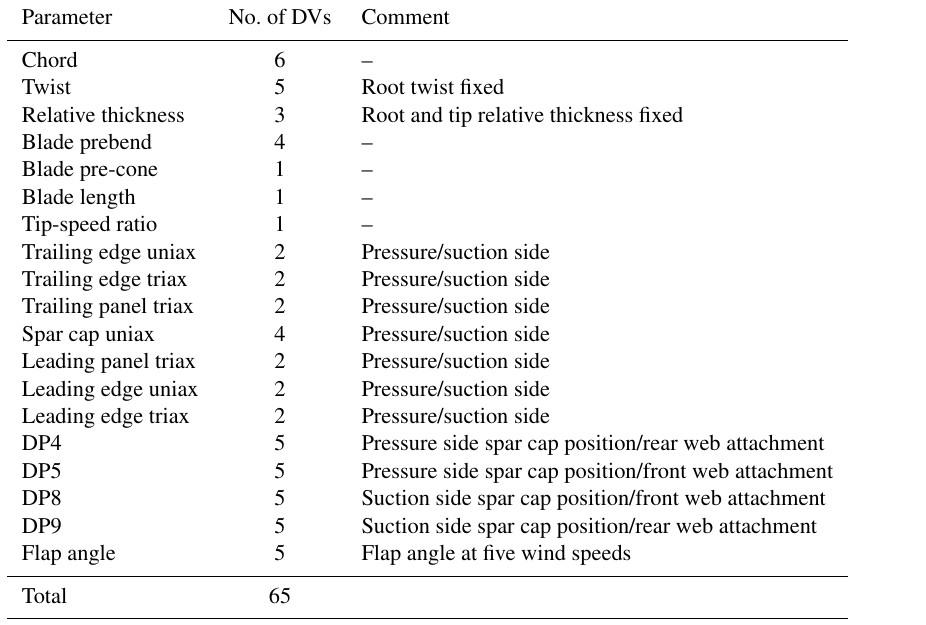
Table 3. Summary of design variables.